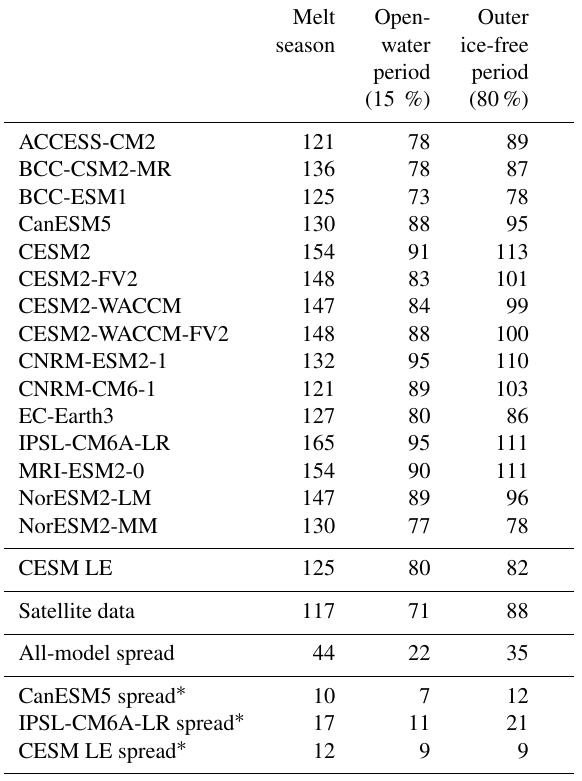
Table 5. Lengths of pan-Arctic, satellite-era (1979–2014) means of interseasonal transition periods in days. The satellite-era means and the all-model spreads (latest minus earliest) are calculated using the first ensemble member from each model. Models labeled with ∗ show the spread in means between the first 30 ensemble members of that model. Model spreads are given in days, and all metrics are calculated between 66 and 84.5 ◦ N. Melt Open-